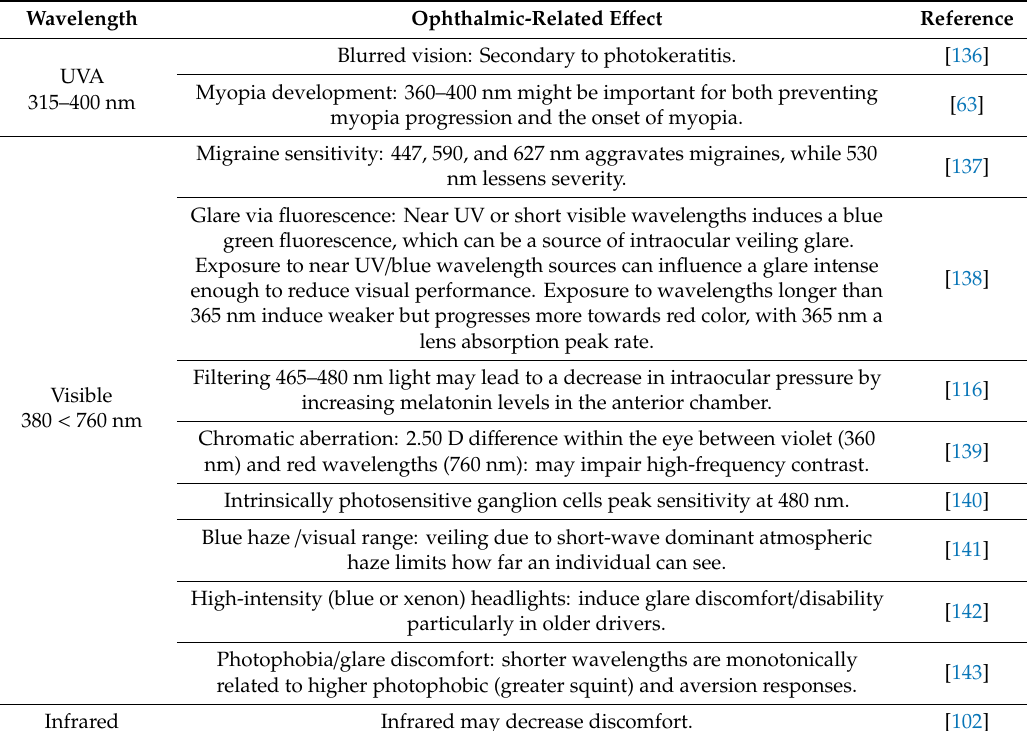
Table 6. The relation of wavelength to other ophthalmic-related